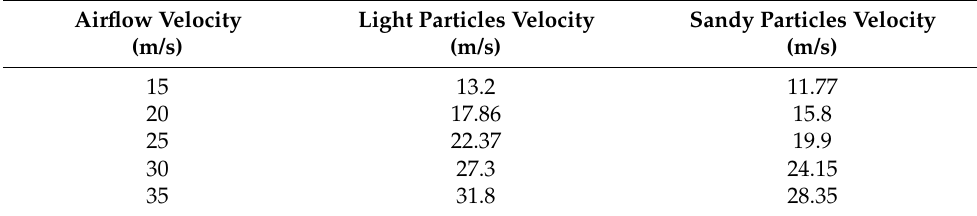
Table 5. Values of airflow and particle velocity at the air intake of the pickup